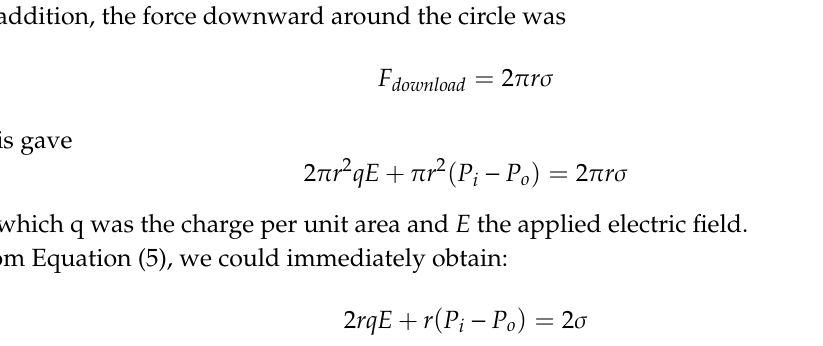
Figure 3. Diagram of the function between 𝑟 and Q. Similarly, if 𝑟 was a constant, then the following relational expression could be obtained 2𝑞𝐸𝑟 + 𝑟(𝐵𝜌 (cid:3036) − 𝑃 (cid:3042) ) − 1 2 𝑟𝜌 (cid:3036) ( 1 𝐴𝜌 (cid:3036) ) (cid:2870) 𝑄 (cid:2870) = 𝜎 (13) So, when the critical bubble was controlled at the same size, the relationship between the applied electric field and the incoming gas would be 𝐸 = 𝜎 − 𝑟(𝐵𝜌 (cid:3036) − 𝑃 (cid:3042) ) + 1 2 𝜌 (cid:3036) ( 1 𝐴𝜌 (cid:3036) ) (cid:2870) 𝑄 (cid:2870) 2𝑞𝑟 (14) Hence, the electric field needed the weakest when Q reached (cid:4670) (cid:3045)((cid:3003)(cid:3096) (cid:3284) (cid:2879)(cid:3017) (cid:3290) )(cid:2879)(cid:3097) (cid:3044)(cid:3096) (cid:3284) ( (cid:3293) (cid:3250)(cid:3344)(cid:3284) ) (cid:3118) (cid:4671) (cid:3117) (cid:3118) , just as shown in Figure 4, the electric field became the weakest.